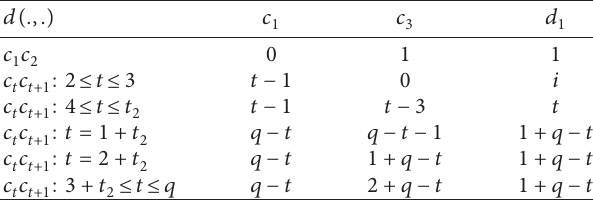
Table 4: Codes of outer edges of GP ( q, 1 ) when q is even. d ( ., . )